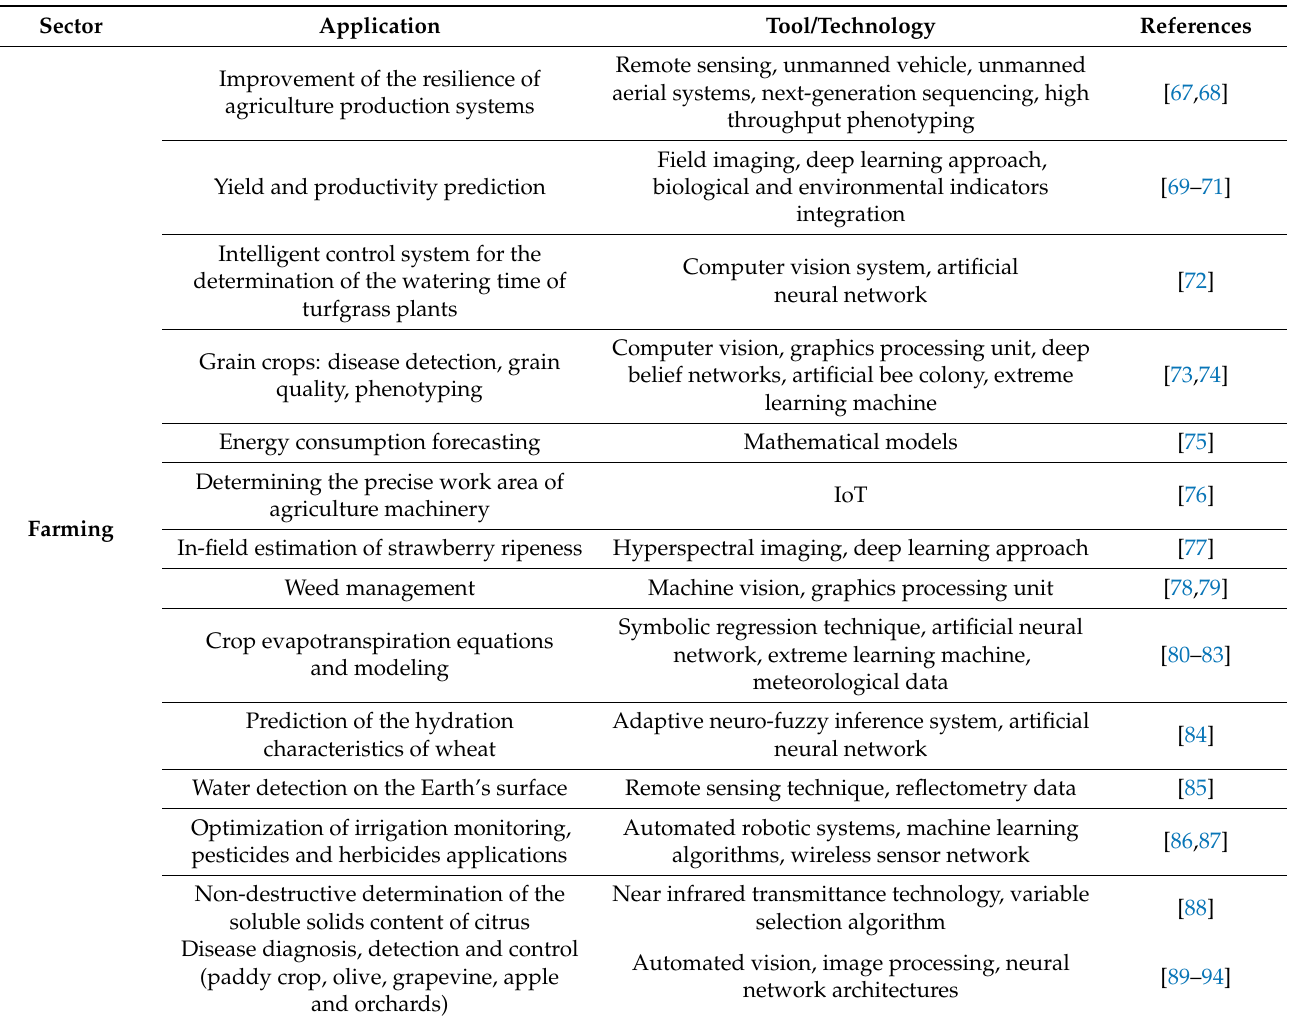
Table 2. Different kinds of recent AI applications in